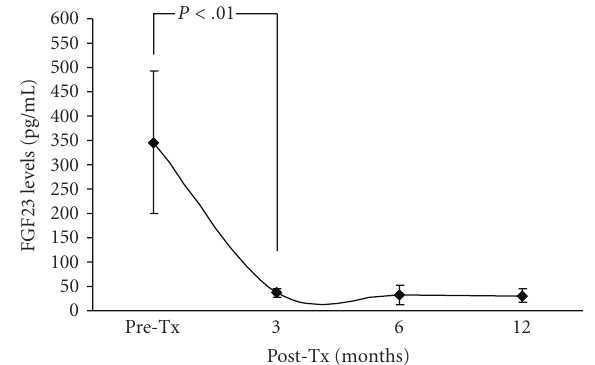
Figure 1: FGF-23 levels before and after successful renal transplan- tation (Tx: renal